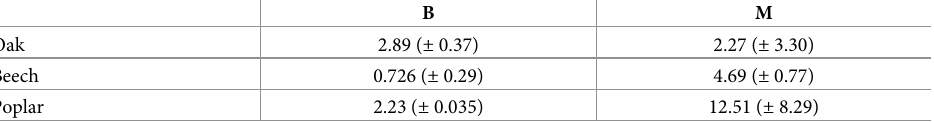
Table 3. Summary of mean values and standard deviation of values of B and M parameters computed from stem shapes at gravitropic and photogravitropic equilibrium, respectively, for three species: Oak, beech and